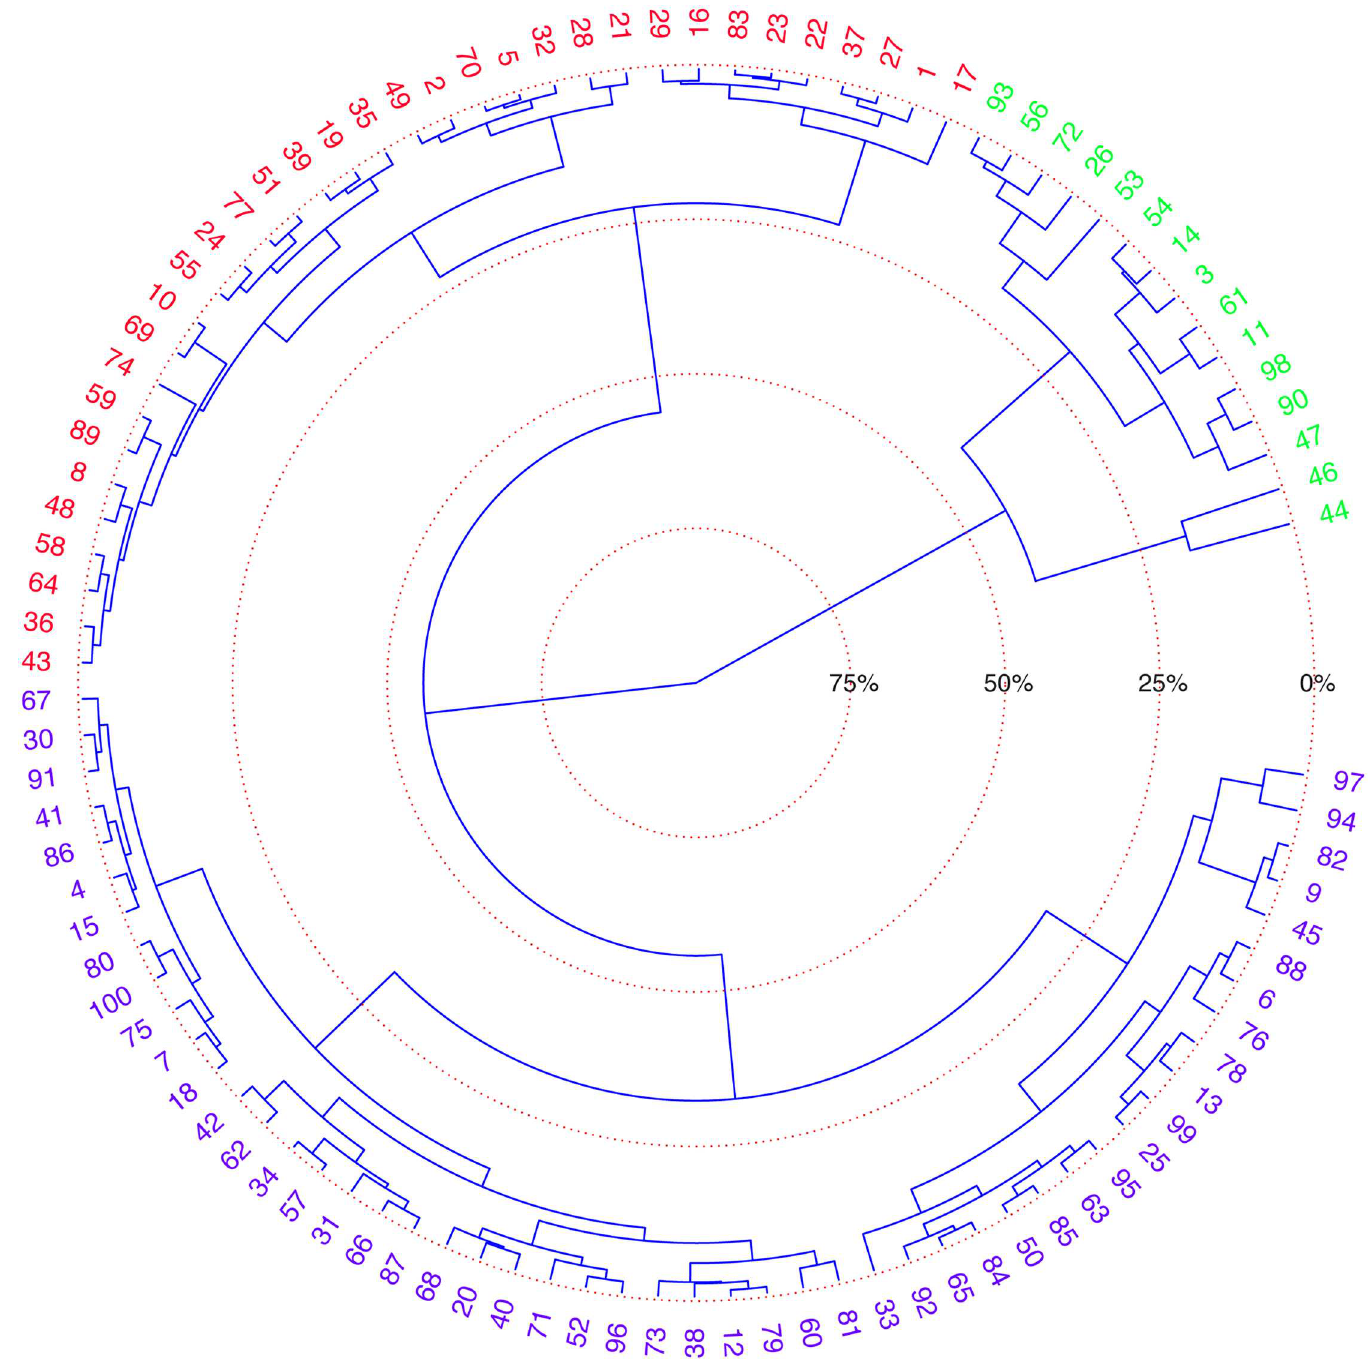
Fig 5. Neighbor-joining, rooted, circular dendrogram clustering of genuine signatures by entropy: H1, H2, and H3, in red, blue, and green, respectively.